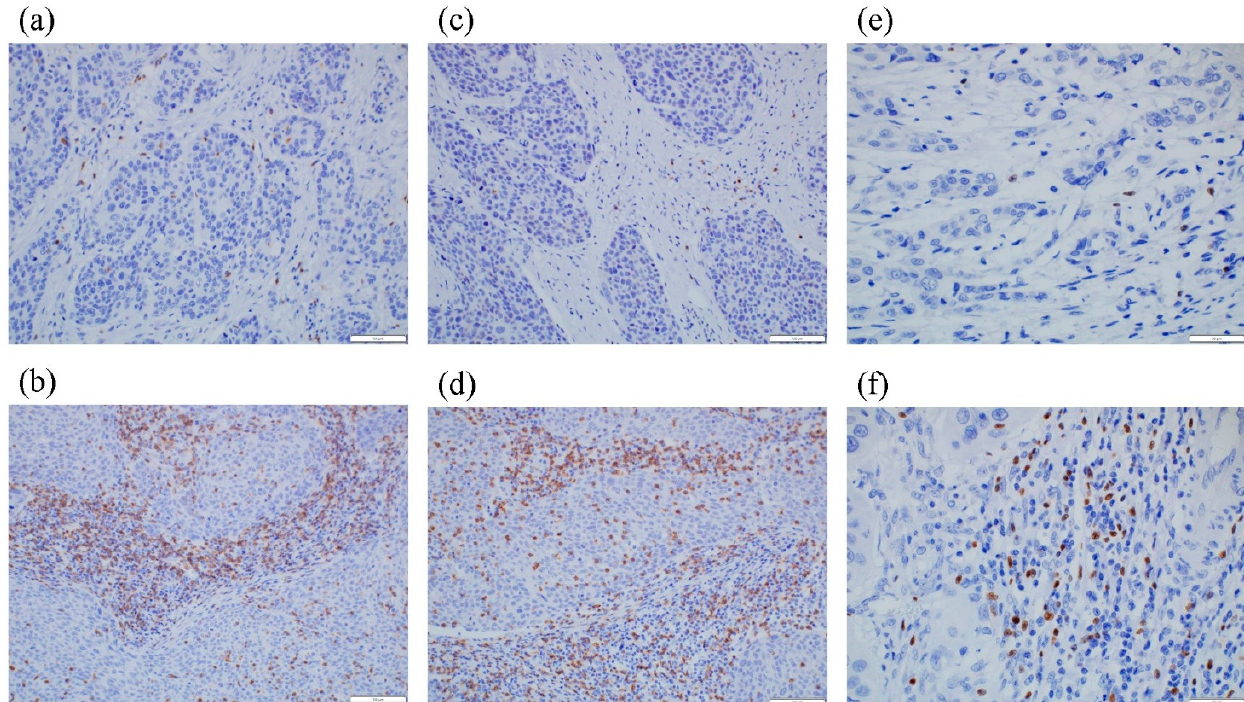
0.111 Abbreviations: HR, hazard ratio; CI, confidence interval; NAC, neoadjuvant chemotherapy; MLKL, mixed lineage kinase domain-like protein; pMLKL, phosphorylated MLKL. 3.5. Correlations between the Necroptotic Biomarkers and TILs in ESCC We then examined the correlations between the status of the necroptotic markers and the density of TILs in post-NAC residual tumors. Representative images of CD3, CD8,